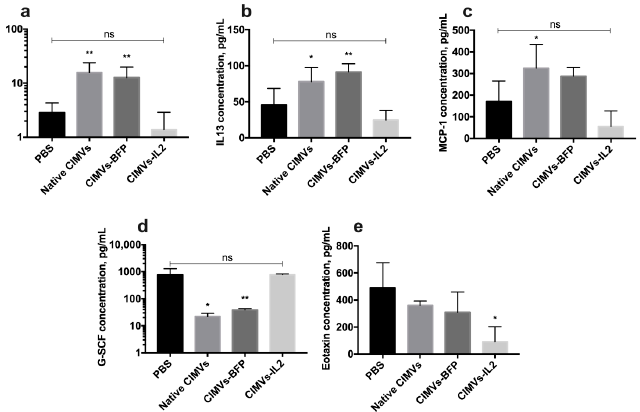
Figure 11. Changes in the cytokine profile of mice after injection of native CIMVs, CIMVs-BFP or CIMVs-IL2 using the Bio-Plex Pro Mouse Cytokine 23-plex panel. After 72 hours, the levels of pro-inflammatory cytokines IL3 ( a ), IL13 ( b ) and monocyte chemoattractant protein 1 (MCP-1) ( c ) were significantly increased in the mice injected with native CIMVs and CIMVs-BFP compared to the PBS group. At the same time, in mice injected with CIMVs-IL2, those cytokine levels remained similar to the PBS control group. The level of granulocyte colony-stimulating factor ( G-CSF) ( d ), which is involved in the immune response to viral and bacterial infections, was reduced in mice treated with native CIMVs and CIMVs-BFP compared to CIMVs-IL2 or PBS only. The secretion of eotaxin ( e ), which is a chemo attractant for eosinophils in autoimmune inflammation, was reduced after the administration of CIMVs-IL2 compared to injection with the other CIMVs or PBS. Each box represents the mean ± SD (n = 4) of four biological replicates. *p < 0.05, **p < 0.01, ns – not sig- nificant.